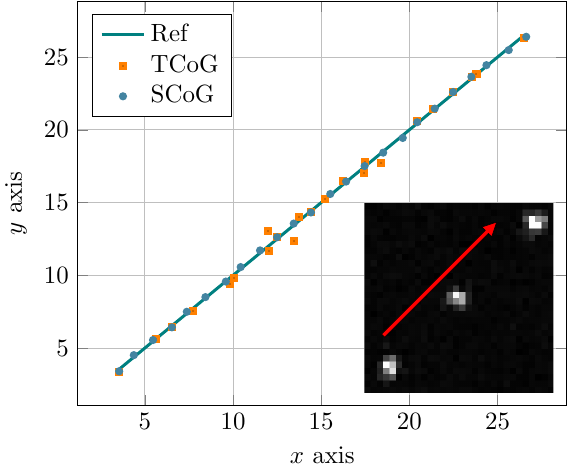
Figure 10. Comparison of hardware implemented SCoG with a traditional thresholding CoG (TCoG) for detecting a moving Gaussian spot.